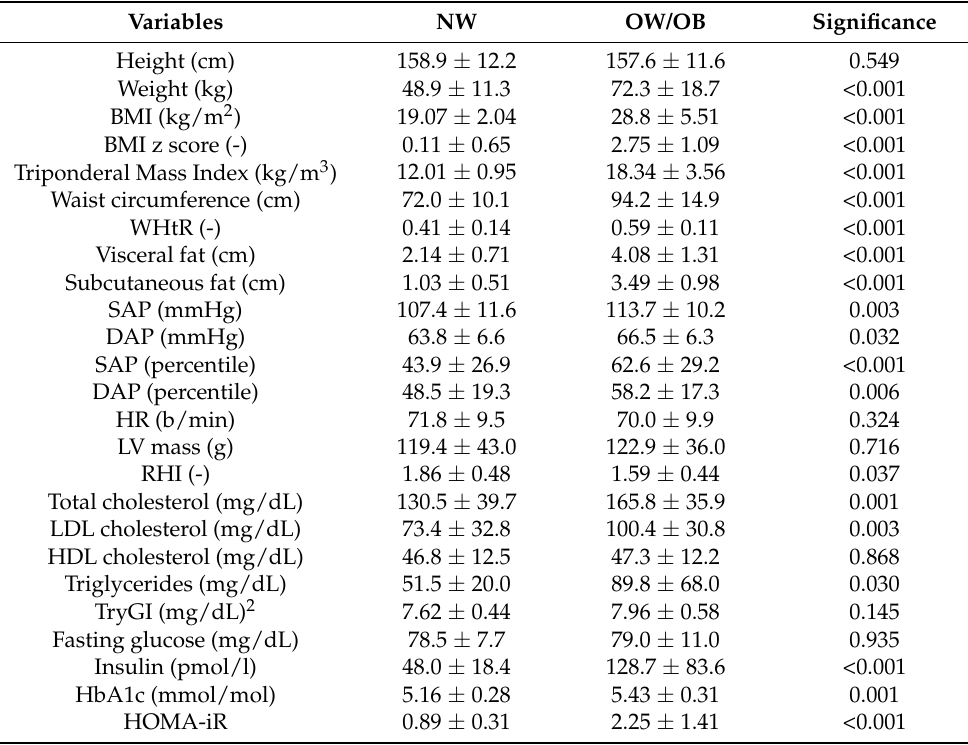
Table 1. Anthropometric, hemodynamic and metabolic data in normal weight (NW) and over- weight/obese children (OW/OB).